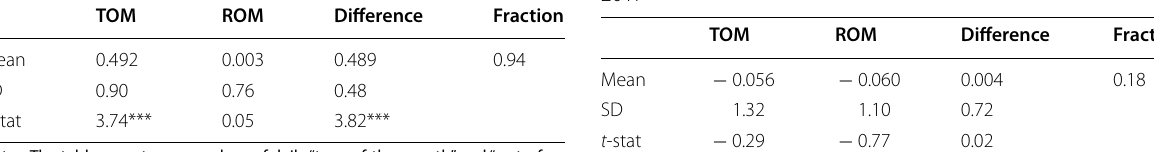
Table 7 T-test of means for “Turn-of-the-Month-Effect” of year